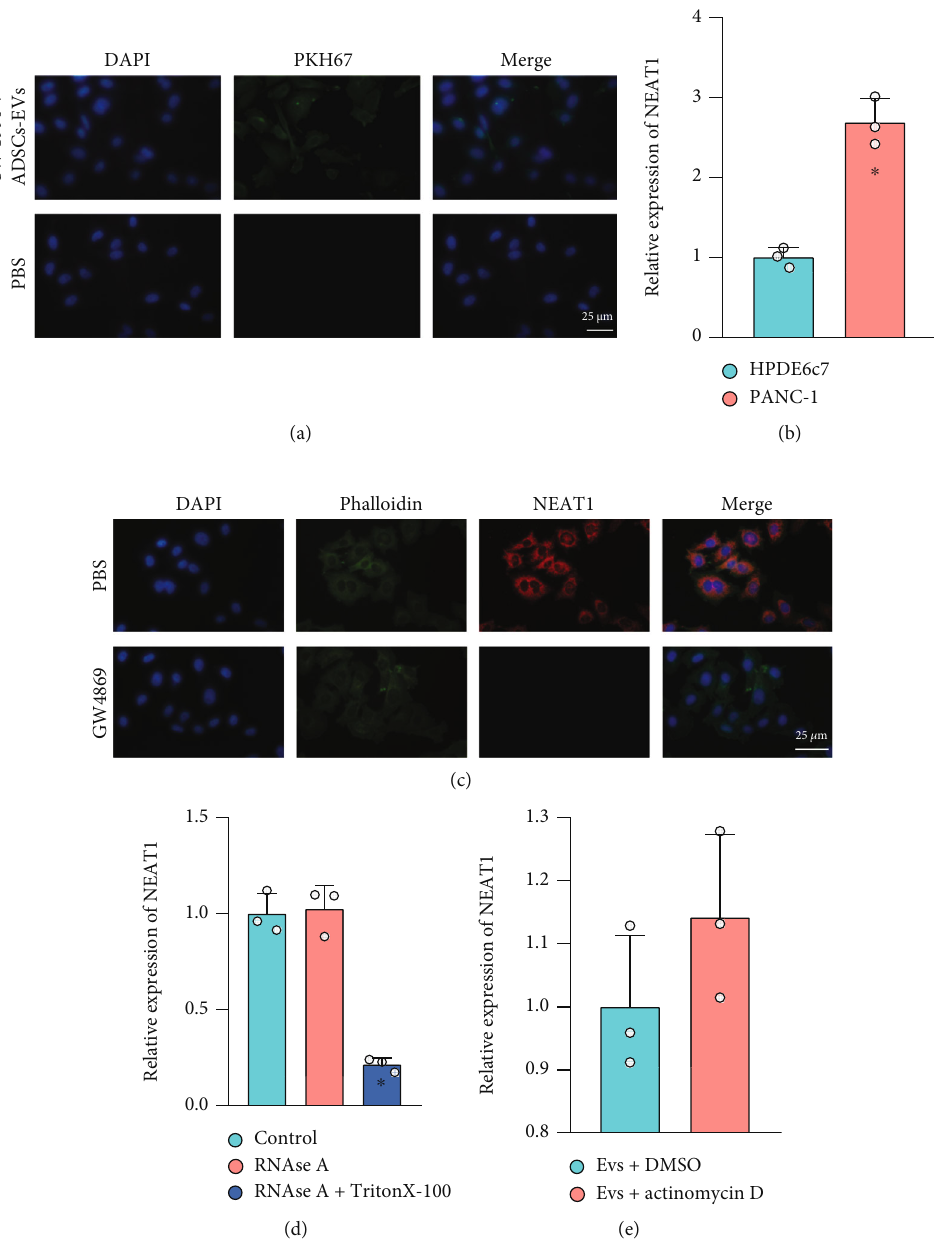
Figure 2: NEAT1 is delivered into PCa cells via ADSC-EVs. (a) Internalization of PKH67-labeled EVs by SW1990 cells under the fl uorescence microscope (scale bar: 25 μ m). (b) NEAT1 expression in SW1990 cells cocultured with ADSC-EVs determined by